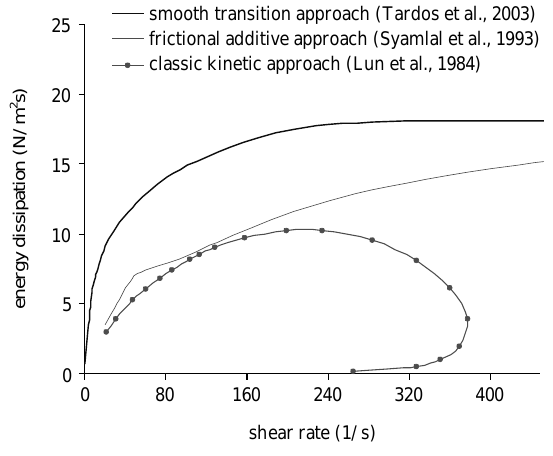
Variation of energy dissipation as a function of shearing rate predicted by various modelling approaches.